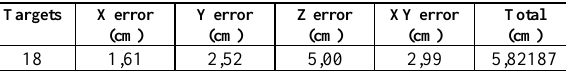
Table 1. Ground control points RMSE